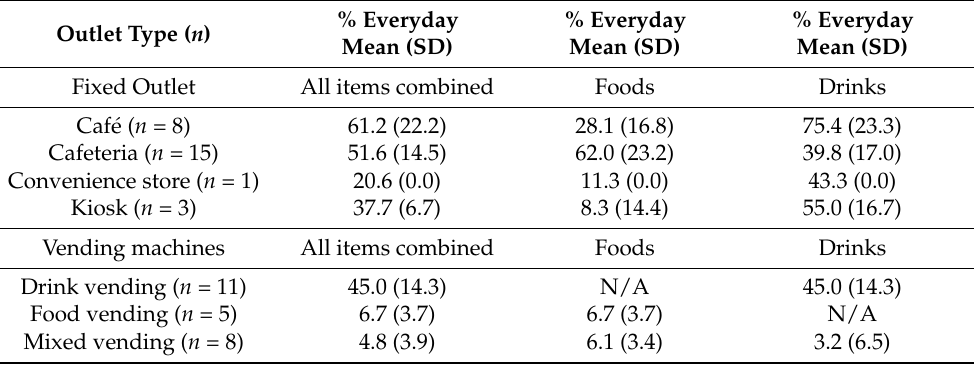
Table 3. The amount of Everyday foods and drinks available for sale as a mean percentage of all products across each outlet type.